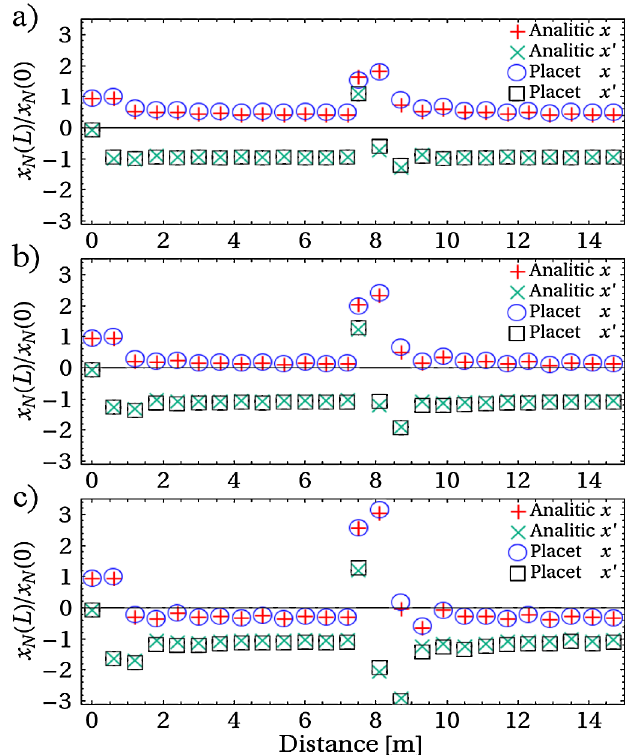
FIG. 6. The normalized amplitudes of the pointlike bunches with constant charge at the end of perfectly aligned DBL for an offset incoming train, (a) FODO, (b) doublet, and (c)